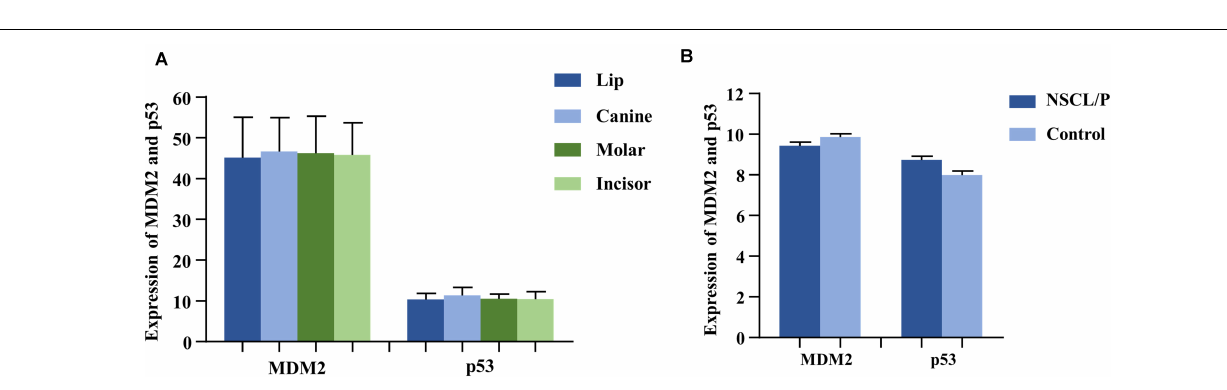
FIGURE 2 | The expression of MDM2 and p53 in human tooth germs (A) from GEO datasets (GSE48150) and dental pulp stem cells (B) from GEO datasets (GSE42589). NSCL/P, non-syndromic cleft lip with or without cleft